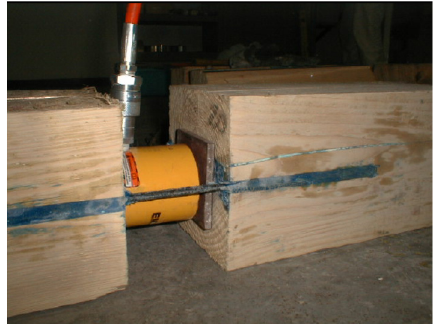
Figure 7. Pull-out test arrangement (tests without strain